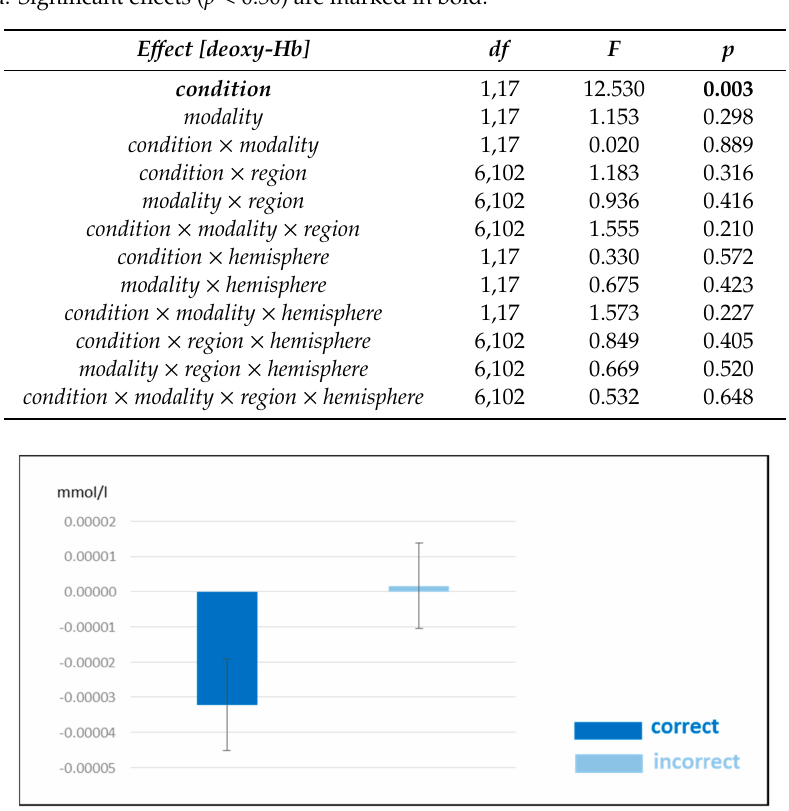
Figure 6. fNIRS results for [deoxy-Hb]. Beta-values for correct and incorrect sentences merged across spoken and sung sentences and across all channels including SEMs. Please note that a more negative value indicates an increased